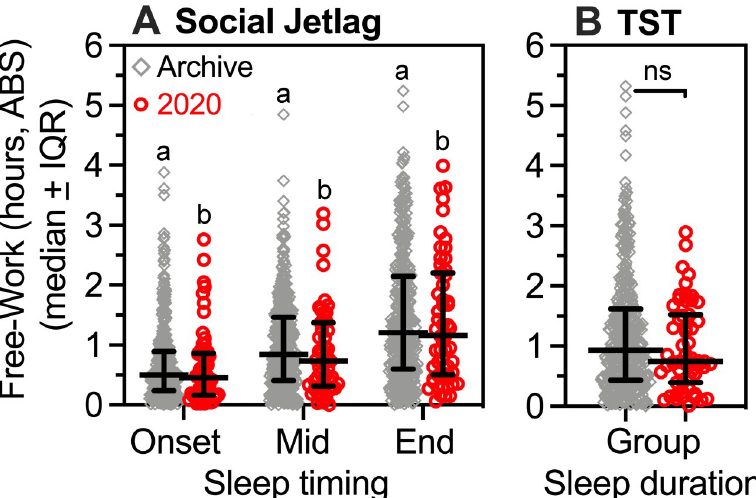
Fig 6. Differences between work and free days in sleep timing (social jetlag) and sleep duration. [ A]. Absolute value of differences between work and free days in sleep onset, midsleep, and sleep end in the archive (grey diamonds) and 2020 groups (red circles). Variables within groups that share a letter (a or b) are significantly different from each other by Friedman test (archive group N = 422, χ 2 2 = 256.7, p < .0001; 2020 group N = 55, χ 2 2 = 32.2, p < .0001). [B]. Absolute value of differences between work and free days in total sleep time. In panels A and B, differences between groups are not significant (Mann-Whitney U tests).